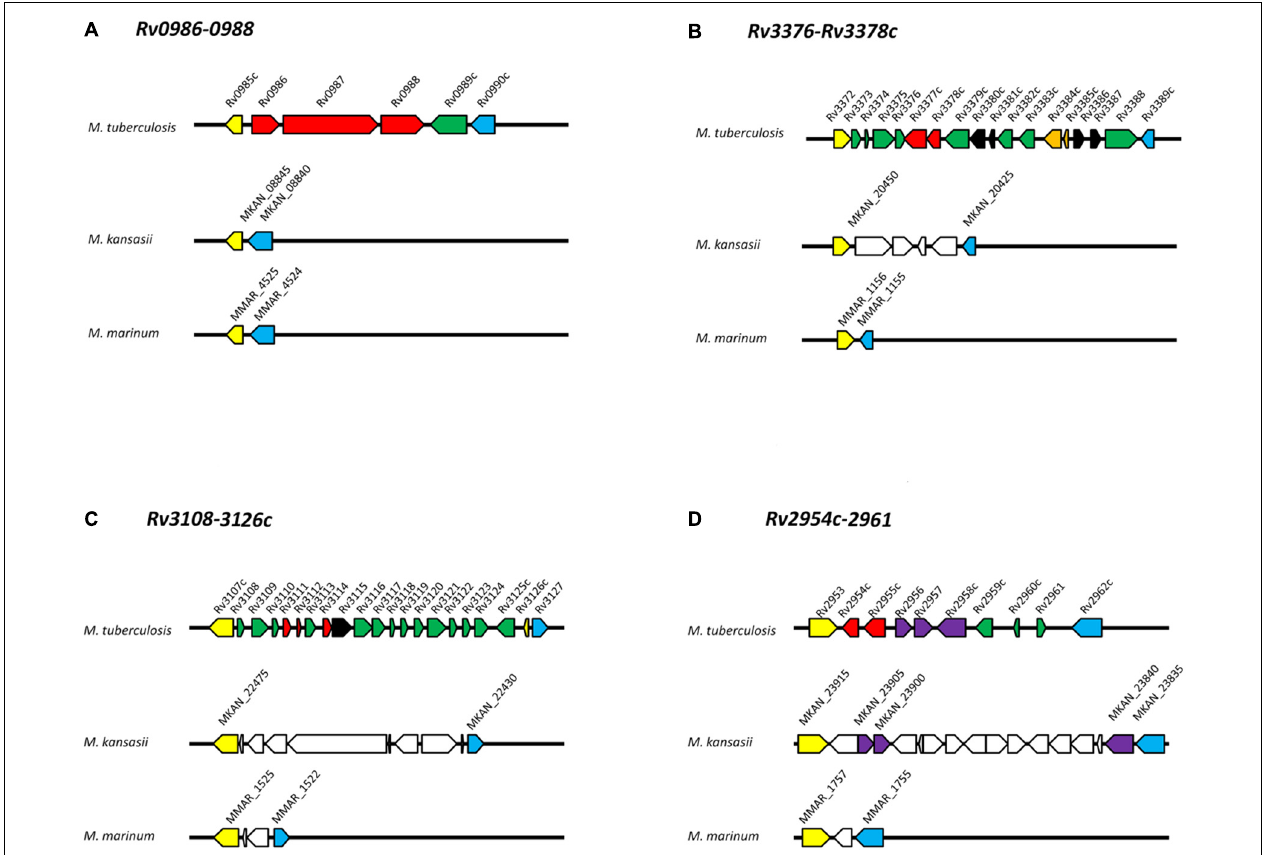
genes present but not orthologs to M. tuberculosis genes. Black arrows indicate transposases; orange arrows indicate toxin-antitoxin genes. Genome organizations for M. tuberculosis , M. kansasii , M. marinum and gene clusters were obtained from the Kyoto Encyclopedia of Genes and Genomes (http://www.kegg.jp/) based on databases available at the Sanger Institute, Tuberculist, and McGill University, respectively. Orthologs were verified by comparing each predicted protein against the H37Rv genome using the BLAST program. Only proteins with > 50% coverage, 60% identity and E-value < e − 20 were